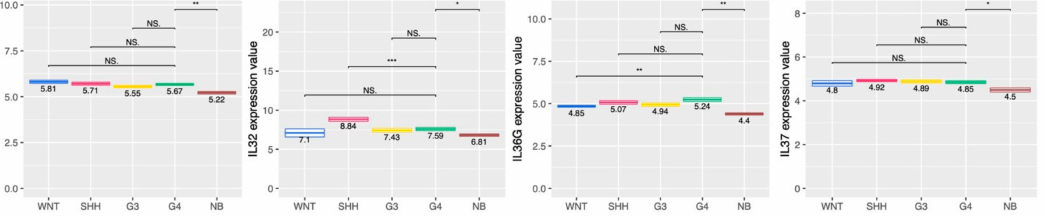
Figure 5. Expression of IL-23A, IL-32, IL-36 γ , and IL-37 in different MB subgroup tumors and normal brain. The expressions of IL-23A, IL-32, IL-36 γ , and IL-37 among 4 subgroups of MB tumors and normal brain tissue were analyzed from the transcriptome data. *, p < 0.05; **, p < 0.01; ***, p < 0.001, compared to G4 subgroup tumors. NS: no significant difference.